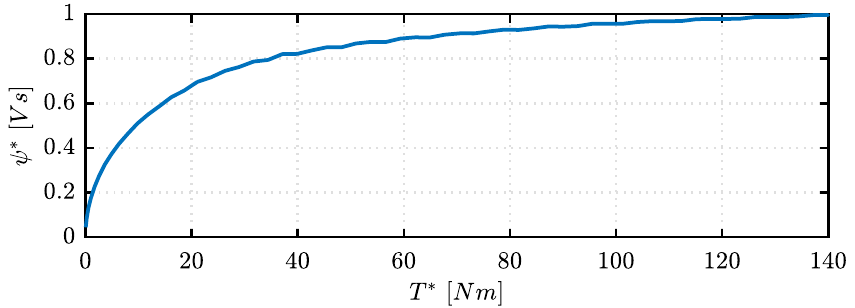
Figure 19. MTPA trajectory for